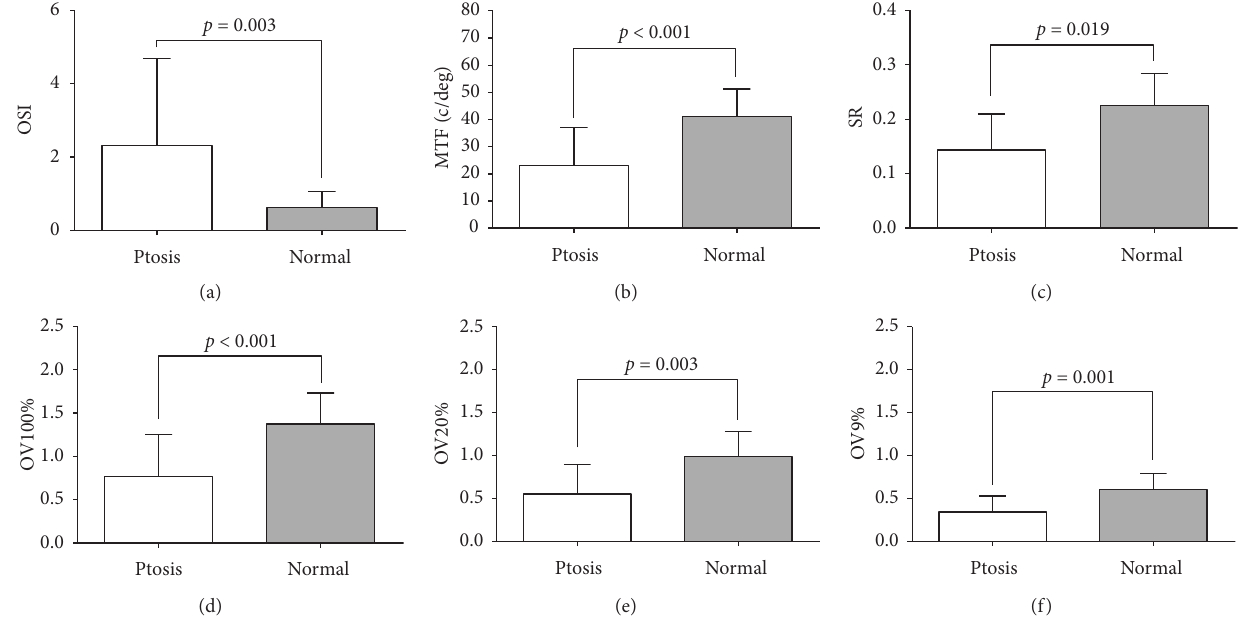
Figure 4: Comparisons of the OQAS parameter between the ptosis group and the normal group. Table 4: The correlation between the corneal HOAs and VFH. Anterior corneal Posterior corneal surface